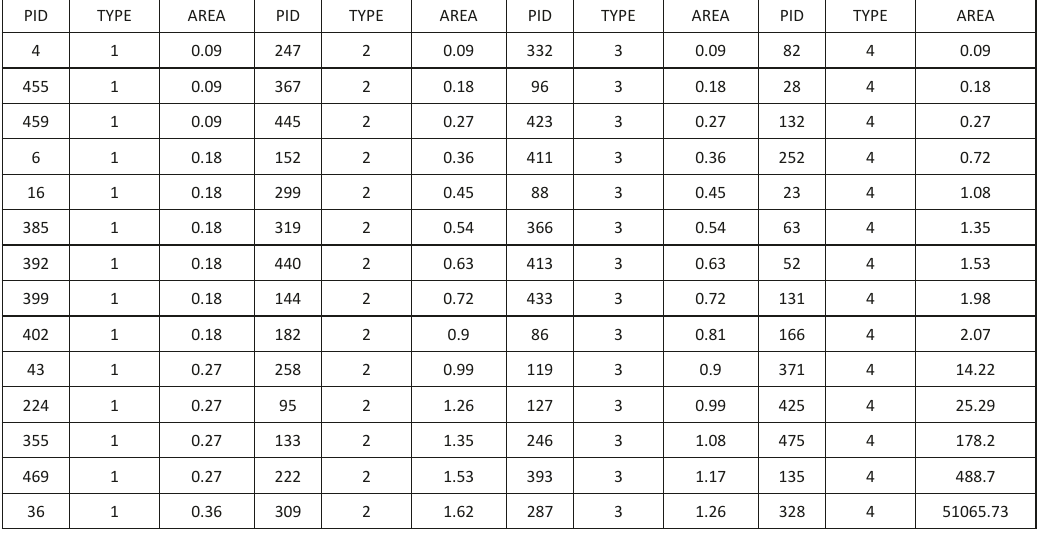
Table 3. Patch metric results